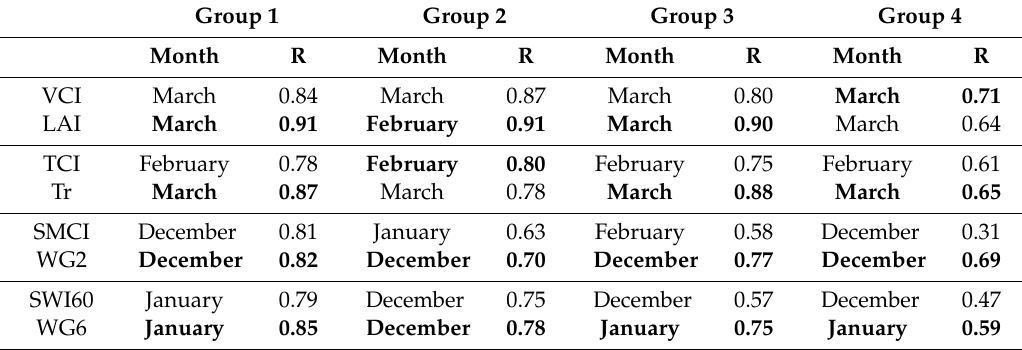
Table 6. Correlation of the LDAS outputs and the remote sensing indices with cereal yields at the correlation peak. The best correlation coe ffi cients R are reported in